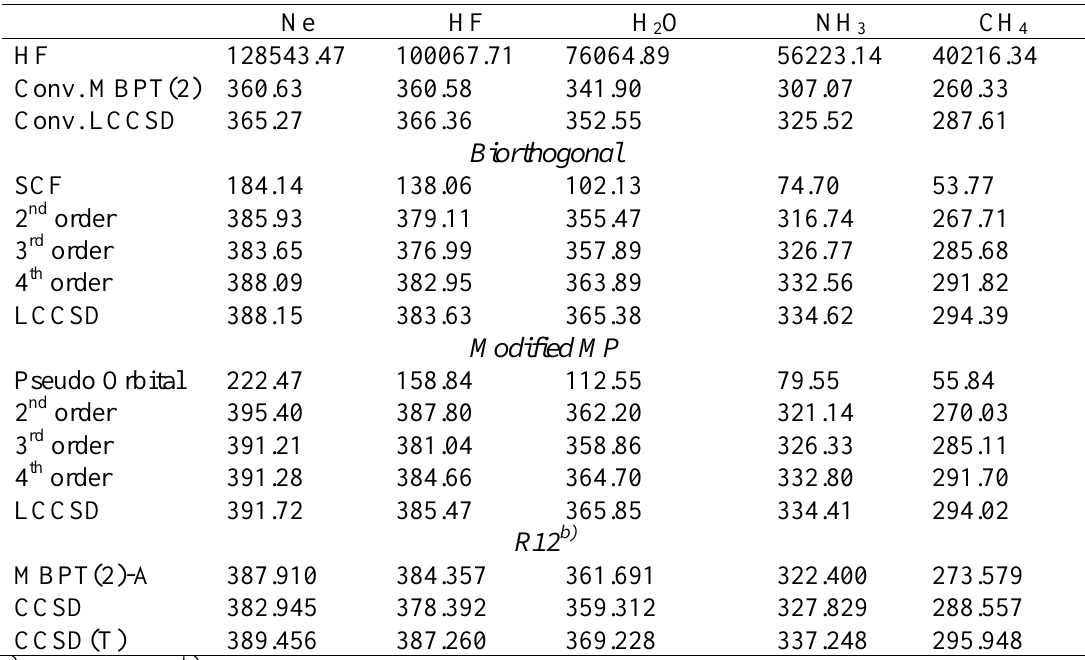
O, NH and CH molecules with 2 3 4